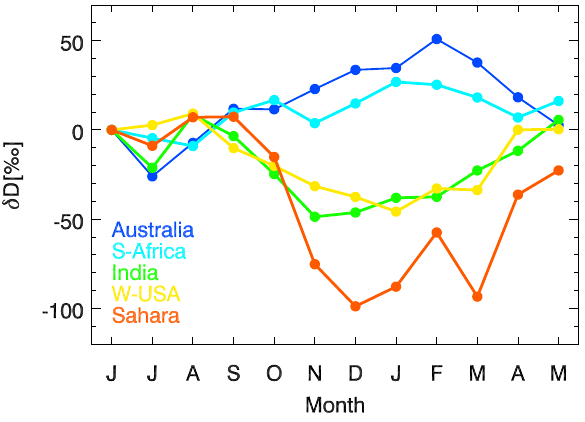
Fig. 15. Seasonal cycle in δ D for 5 regions inferred from quality- filtered GOSAT retrievals between June 2009 to May 2010. The δ D values have been normalized to June.